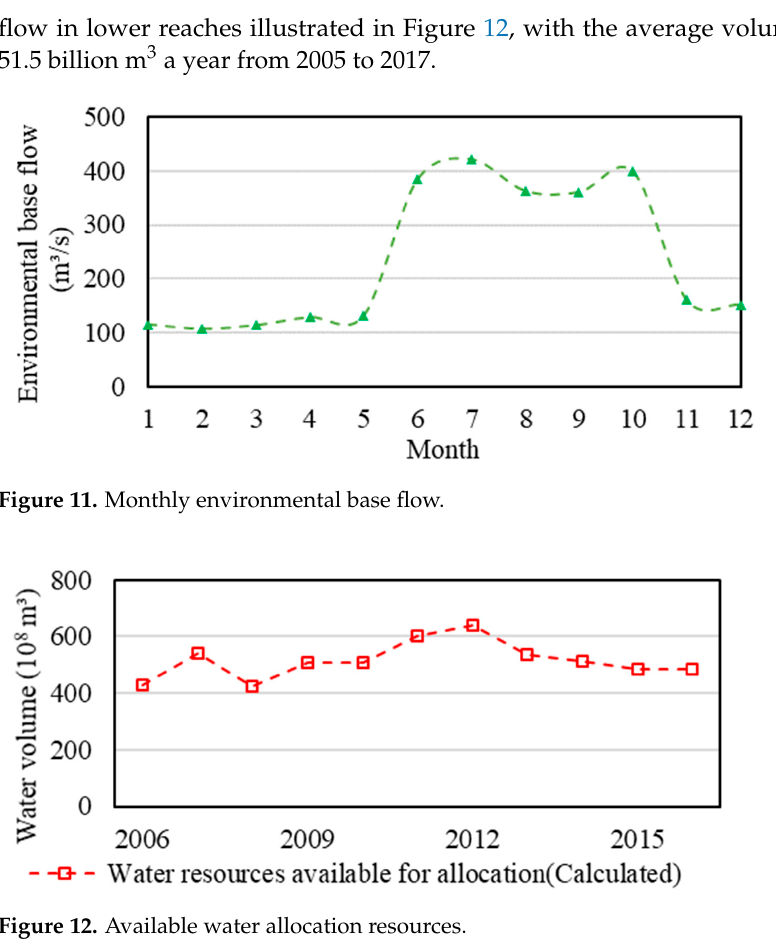
Figure 12. Available water allocation resources.